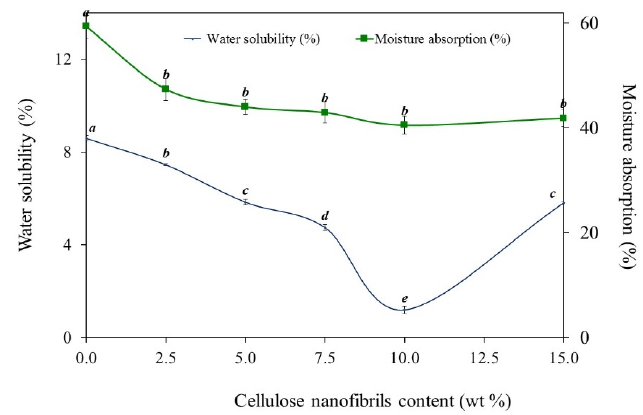
Figure 6. Effect of CNF content on the moisture absorption and water solubility of alginate/CNF films (lower case letters (a, b, c, d, e) show Duncan grouping; distinct letters represent means significantly different ( p < 0.05)).